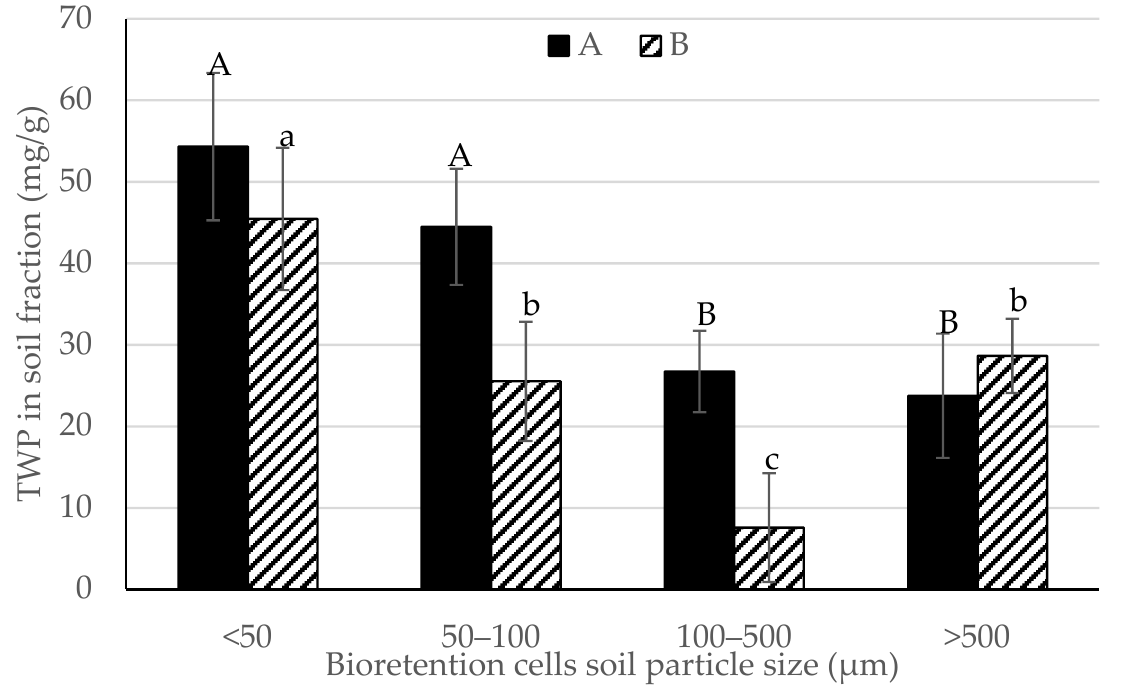
Figure 3. Tire wear particles (TWP) concentrations (mg/g, mean and one standard deviation, n = 3) per soil particle size range in soil samples collected from a functional bioretention cell in Drammen, Norway, at the inlet (A), and 5 m away from it (B). Means with different letters are statistically different (Tukey, p < 0.05).